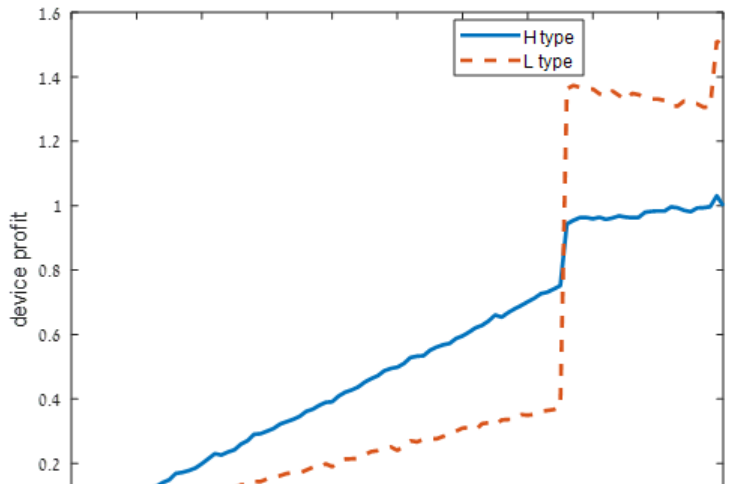
Figure 2. Moderately noisy signal: (cid:101) = 0.3.